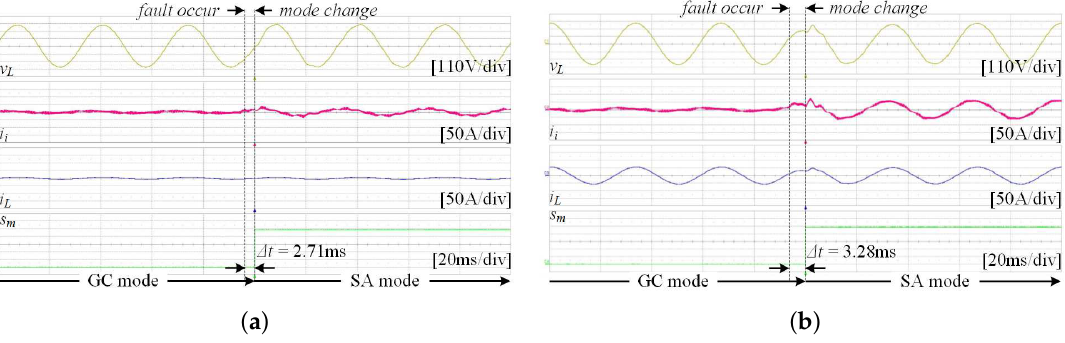
Figure 13. Experimental results of 100 W PCS power with ( a ) 1 kW load ( b ) 30 kW load from grid-connected to stand-alone operation.